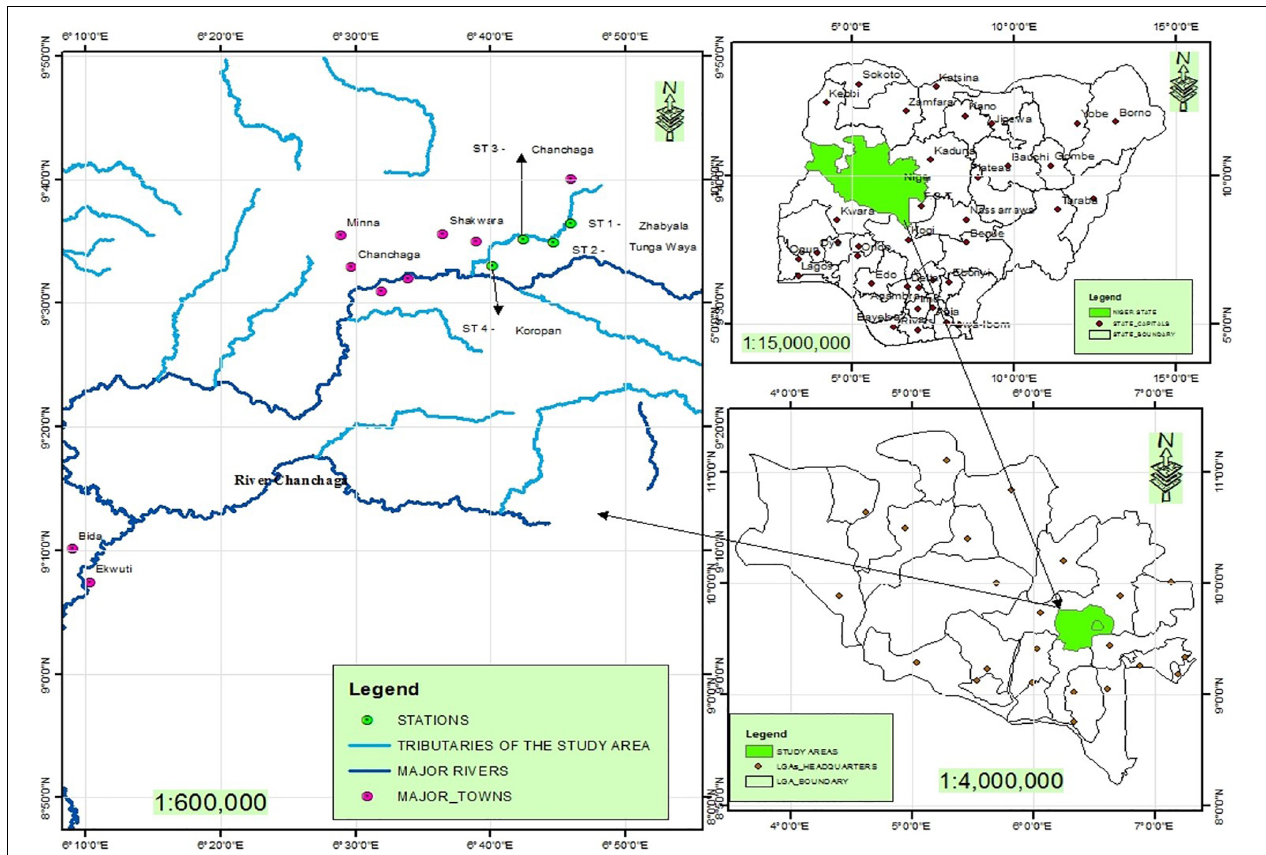
FIGURE 1 | Map of the study area showing the sampling stations, major towns. Source: Remote sensing laboratory, Department of Geography, Federal University of Technology, Minna.